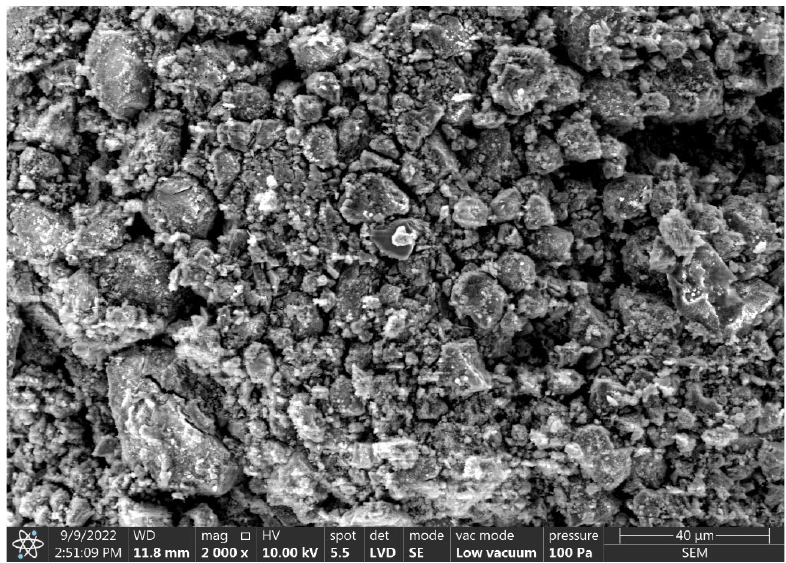
Materials 2022 , 15 , x FOR PEER REVIEW Figure 14. SEM images of the C ‐ 1 agglomerate surface. Figure 14. SEM images of the C-1 agglomerate surface.